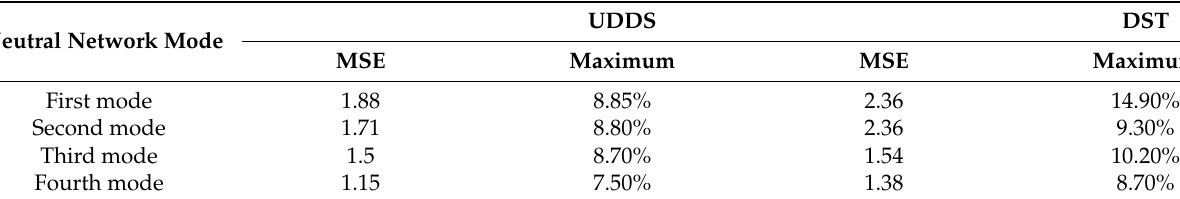
Table 3. Training parameters of the neural network.